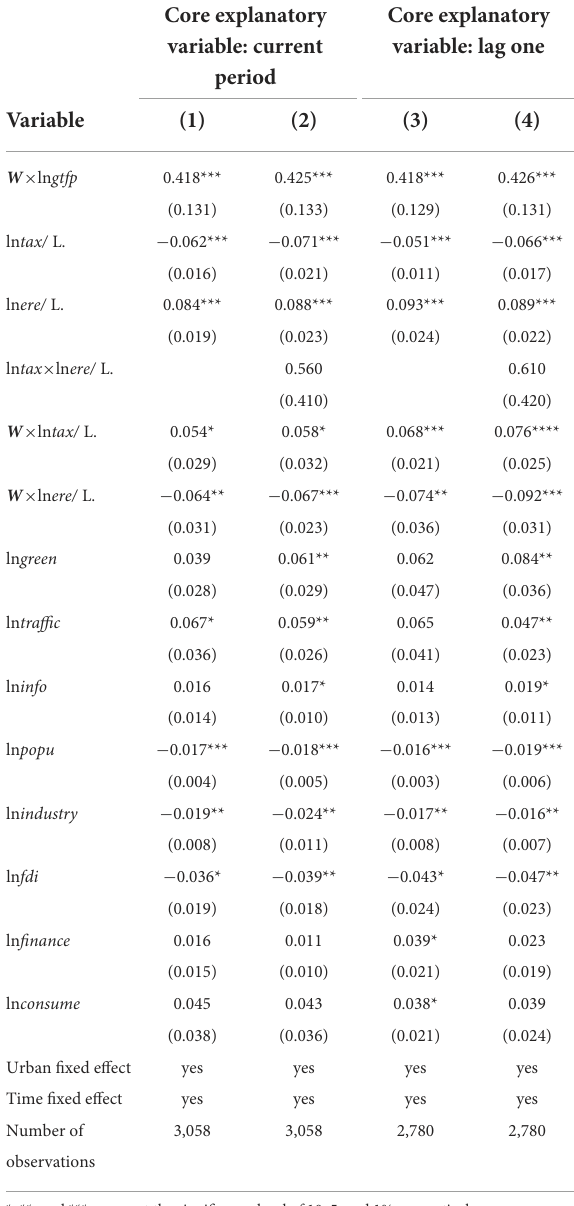
TABLE 4 The regression results of spatial Durbin